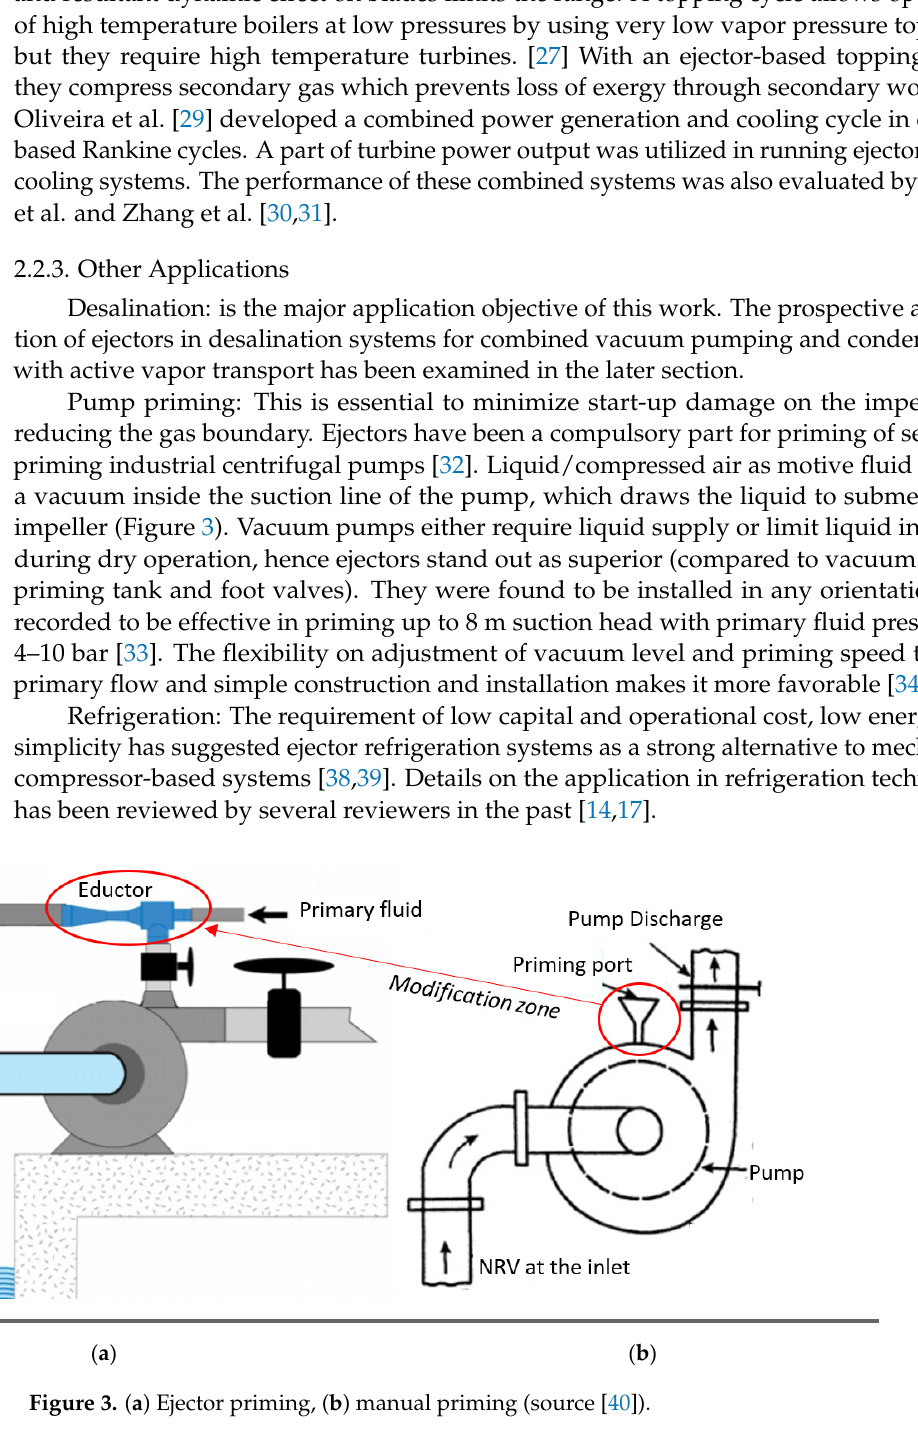
Figure 4. Commercial products available on the market [41–46]. 2.3. Operational Principle In the case of ejectors, the jet passing nozzle induces steady flow eddy current to its surroundings, at the suction chamber, due to momentum transfer, which accelerates the secondary flow. During this momentum exchange of primary fluid into secondary, the secondary phase forms dispersed bubbles inside the primary flow stream. This momen- tum exchange is defined by the momentum exchange coefficient which is a function of drag coefficient, bubble size and phase velocities [47]. The potential energy in two phases is converted to kinetic energy through a special case of Bernoulli—Venturi effect, where flow mixes and accelerates through the mixing chamber. The two-phase mixing results in the induction of pressure shock waves of high frequencies. The accelerated flow with dropped static pressure passes through the throat; this causes further movement of the secondary phase from the suction port into the motive stream. At the diffuser section, velocity decreases and hence the fluid recovers pressure energy and compress the second- ary phase before discharge. Thus far, the system has been able to recover only about 40% of pressure energy. Here, the system is performing three operations at once, causing suc- tion of low-pressure fluid, mixing it with mainstream and discharging at a higher pres- sure. The discharge occurs at an intermediate of motive and suction pressure [48,49].